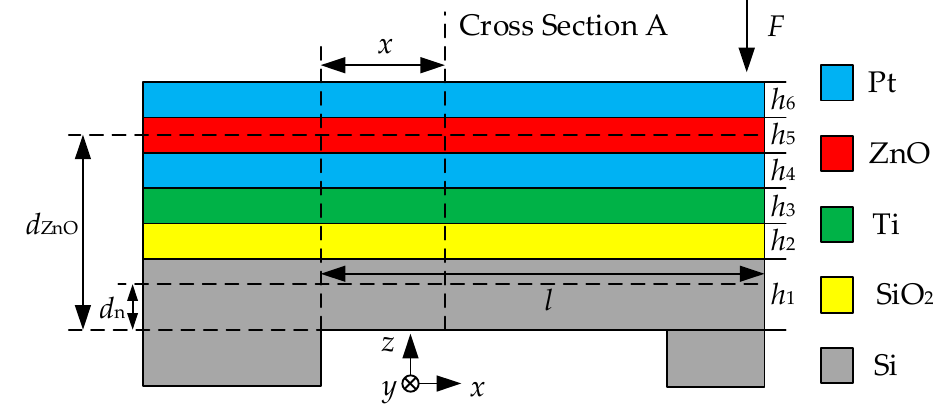
Figure 3. Working principle of piezoelectric PMAS: ( a ) without external acceleration; ( b ) with external acceleration.